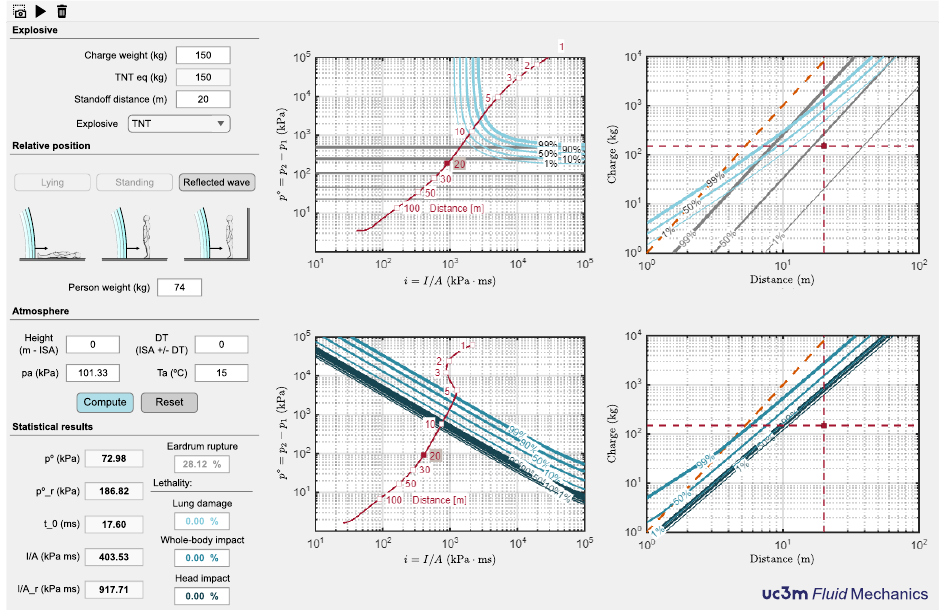
Figure 8. Interface of the assistant for estimating blast-induced damage to people. The CW–S and atmospheric data, along withe the body position relative to the incoming pressure wave, are introduced in the top-left corner, the blast wave parameters and the statistical damage indicators for the chosen CW–S combination appear in the bottom left corner. The right plots represent graphically the statistical damage indicators in the form of overpressure-impulse and CW–S diagrams. Both show the conditions corresponding to the specified CW–S combination with a solid red dot, while the CW–S diagrams include also a diagonal dashed line indicating the approximated position of the fireball radius. Above this line, the Freidlander waveform is not valid, and the blast wave parameters are increasingly imprecise